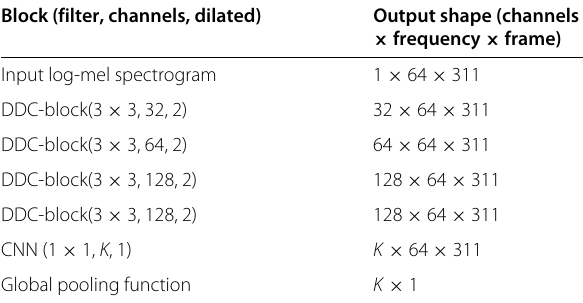
Table 1 Model architecture Block (filter, channels, dilated)